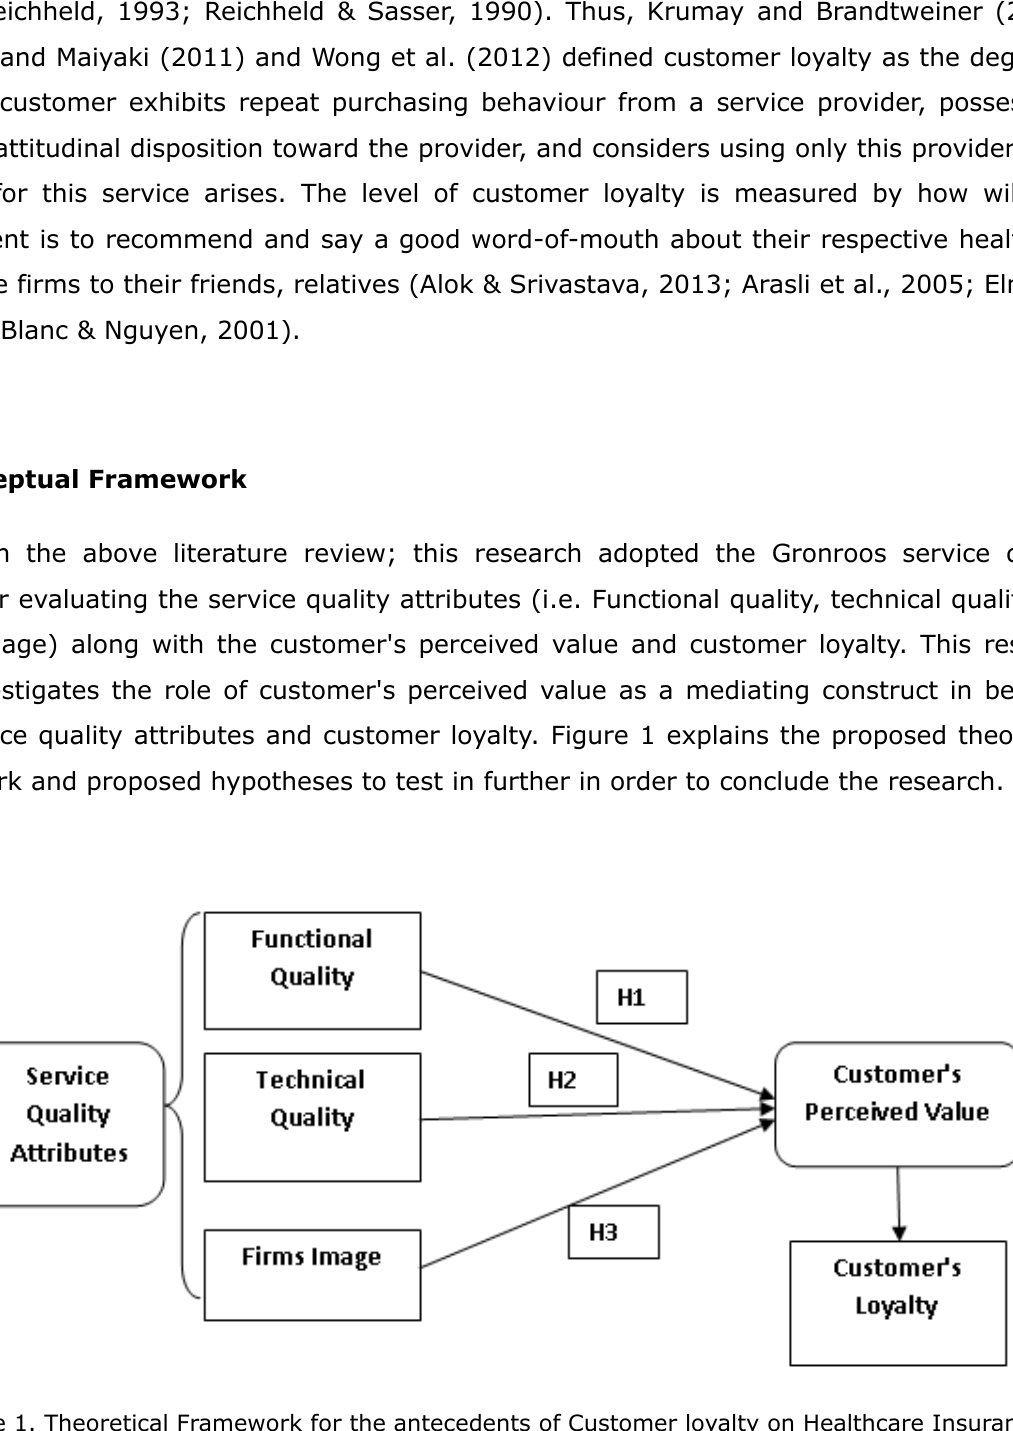
Figure 1. Theoretical Framework for the antecedents of Customer loyalty on Healthcare Insurance Products in